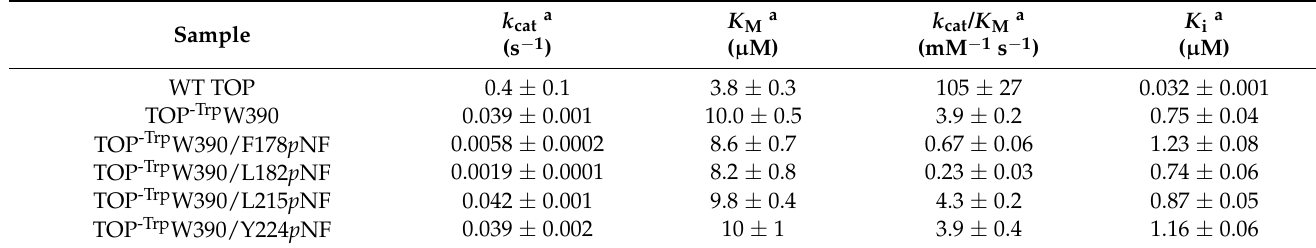
Table 1. Kinetic parameters of TOP proteins for the hydrolysis of substrate QFS and the inhibition constant K i for